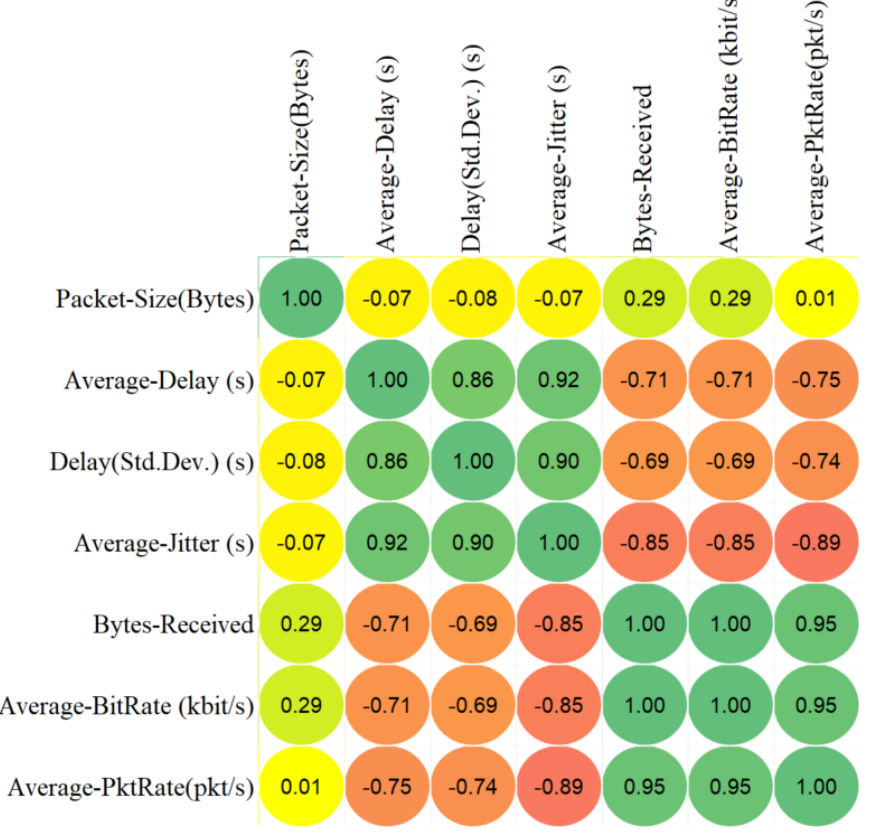
Figure 8. Spearman correlation